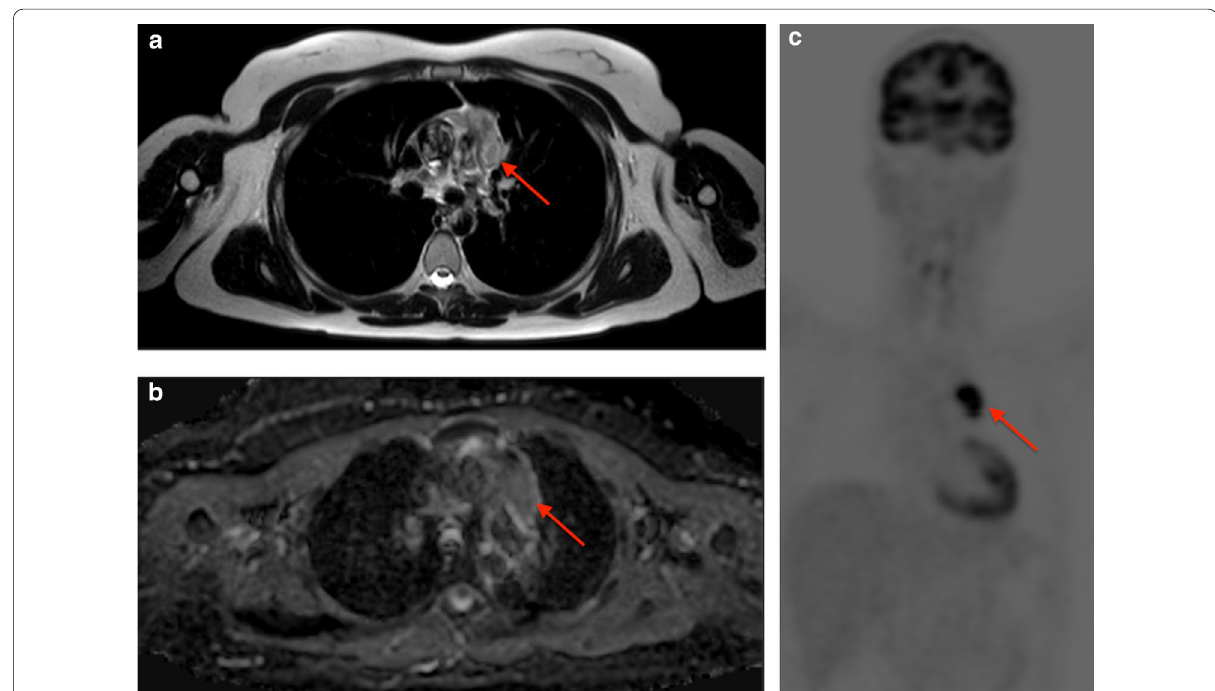
Fig. 3 30-years-old female affected by HL with anterior mediastinal residual mass after therapeutic treatment. MRI showed a tissue with inhomogeneous signal intensity on T2-weighted images a and low values on apparent diffusion coefficient (ADC) map, related to hypercellularity (ADC: 1.3 10 –3 mm 2 /s) ( b ). 18F-FDG- PET/CT showed an avid anterior mediastinal mass (SUV max : 17.4) ( c ). Active residual disease was confirmed by × histopathological